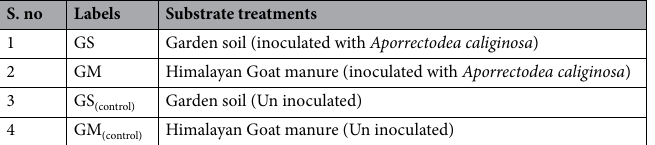
Table 4. Treatment combinations of garden soil and goat